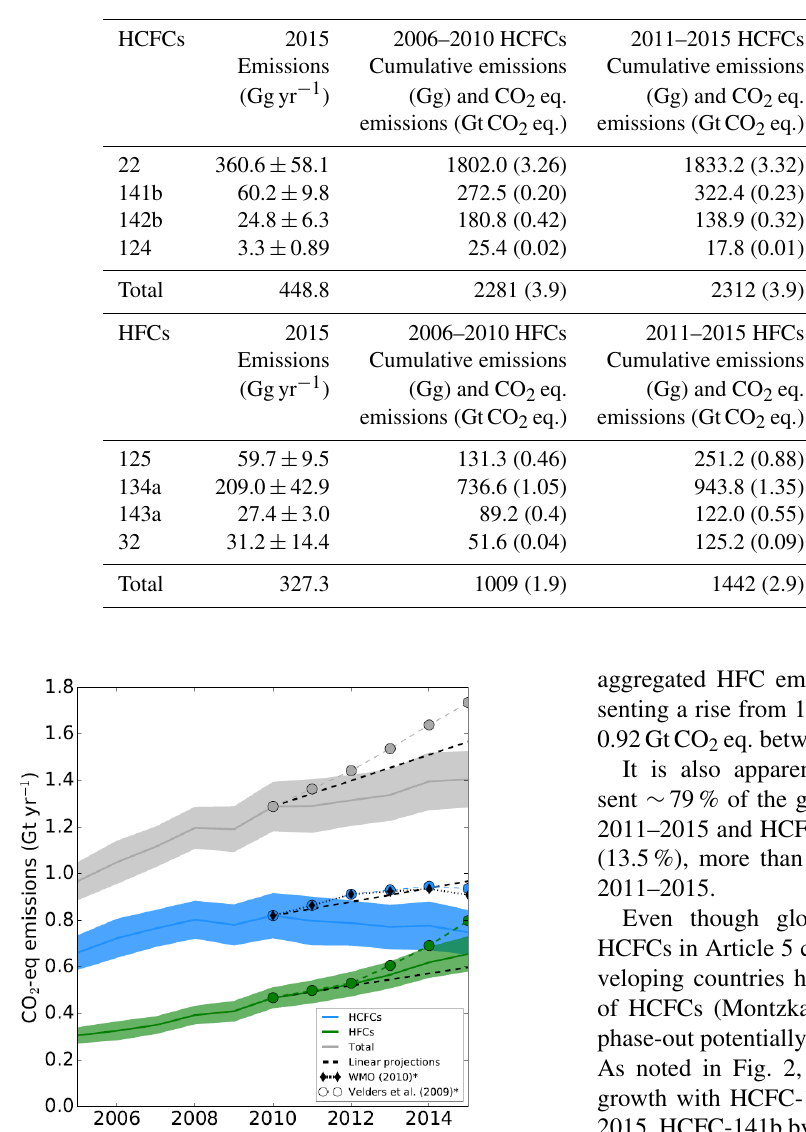
Table 3. Global emissions of HCFCs and HFCs in 2015 and a comparison of the cumulative emissions and the percentage change in emissions over two 5-year periods (2006–2010 and 2011–2015).